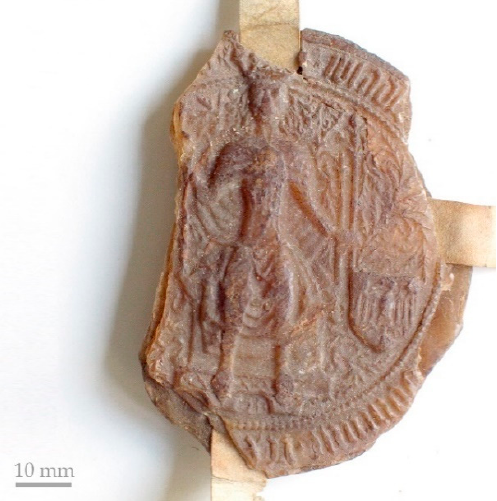
Figure 1. Damaged beeswax seal of the charter RM 722, dated 1495. Photograph courtesy of the Grand Priory of Bohemia of the Order of Malta.